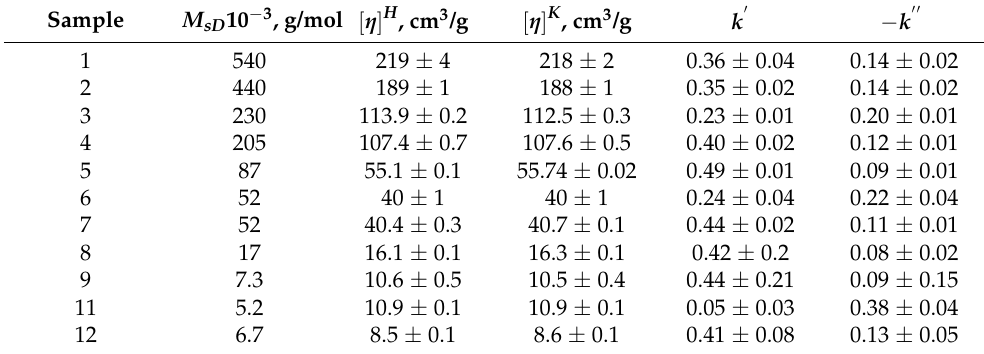
Table 1. The molecular masses M sD , the values of intrinsic viscosities obtained from Huggins ( [ η ] H ) and Kraemer ( [ η ] K ) plots and Huggins ( k (cid:48) ) and Kraemer ( k (cid:48)(cid:48) ) parameters for PMVA in H 2 O at 25 ◦ C. Sample M sD 10 − 3 , g/mol [ η ] H , cm 3 /g [ η ] K , cm 3 /g k (cid:48) − k (cid:48)(cid:48)